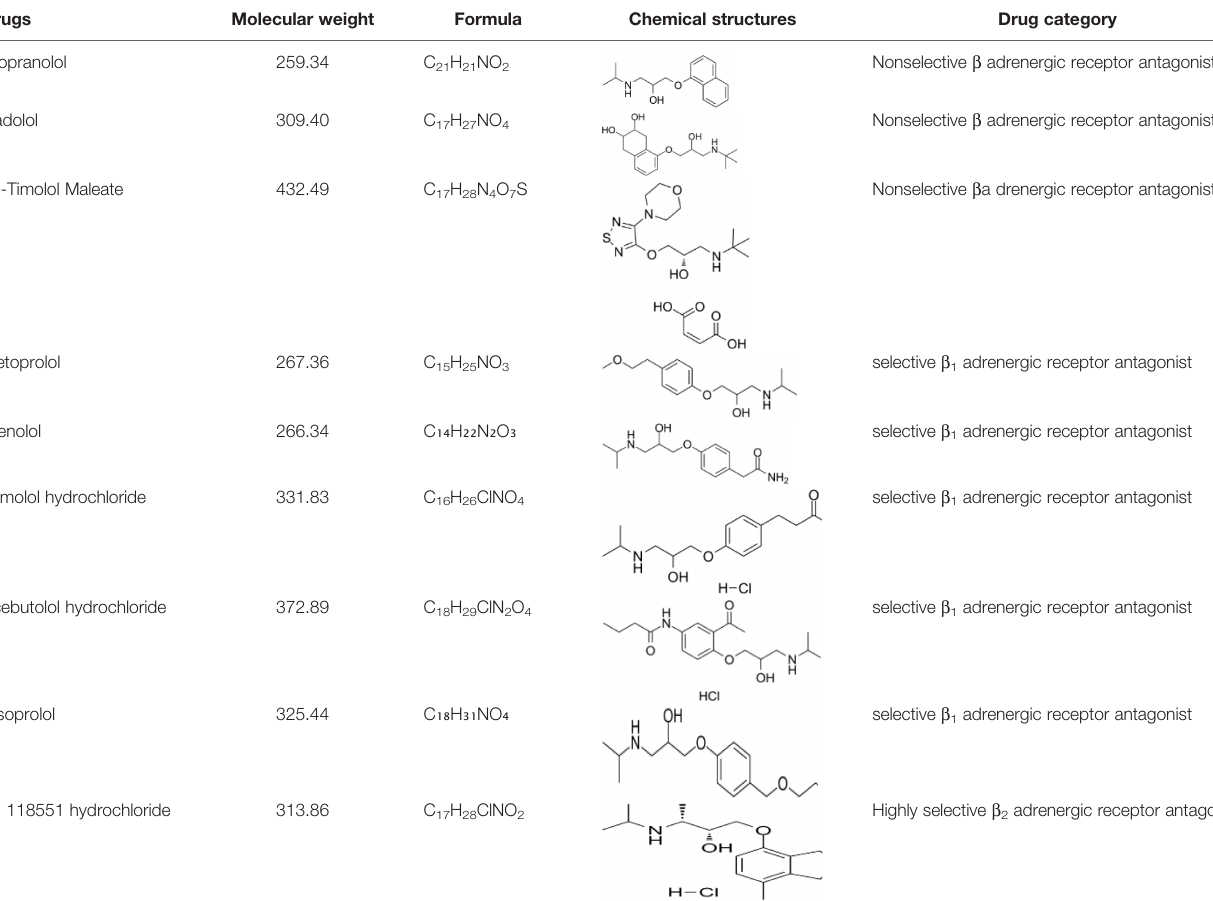
TABLE 3 | Summary of adrenergic receptor